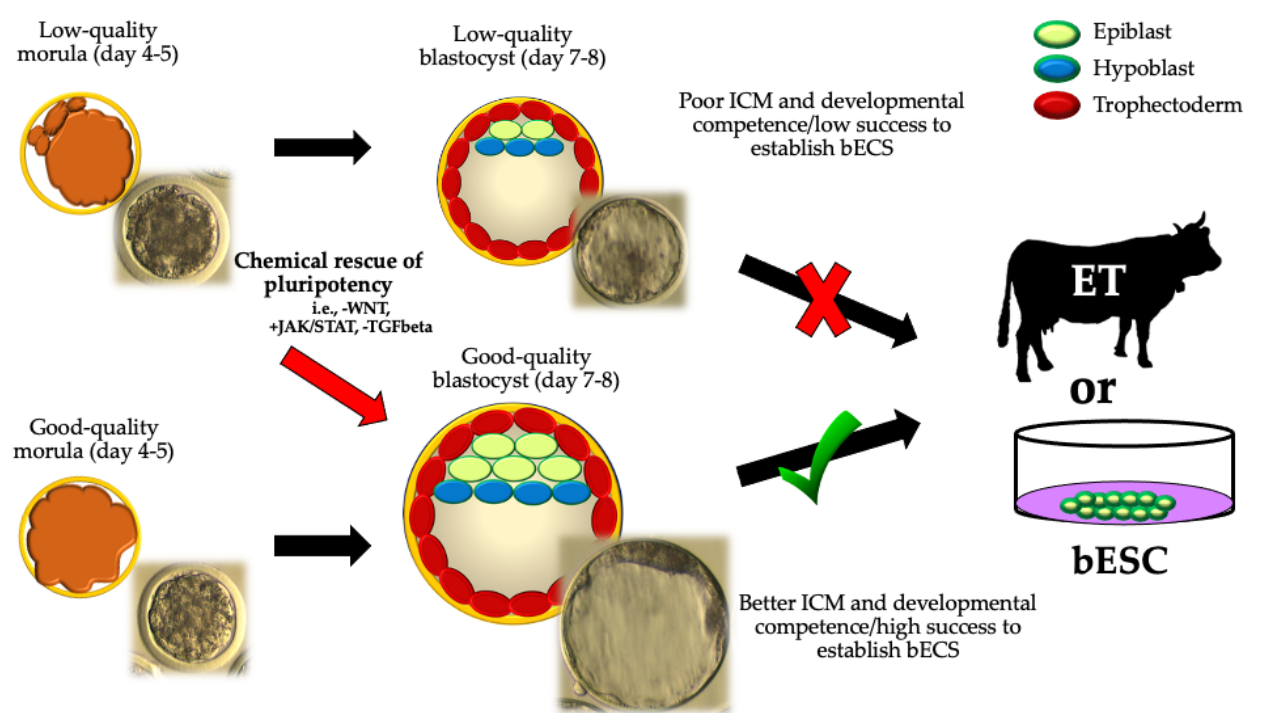
Figure 3. A theoretical approach to “rescue” in vitro developmental potential from cattle embryos of lower quality (seen as morula with delayed compaction, presence of cell debris, fragmentation and/or slower developmental kinetics). ICM: inner cell mass; ET: embryo transfer; bESCs: bovine embryonic stem cells). Low-quality blastocyst: embryo with delayed blastulation, poor symmetry, and/or cells that are loosely packed for the ICM and trophectoderm. Good-quality blastocyst: embryo with an expanded blastocoel cavity, highly symmetric, absence of cell debris or fragmentation, and highly packed ICM and trophectoderm cells, where a clearly visible ICM can be distinguished during morphological valuation. -WNT: WNT-inhibition; +JAK/STAT: JAK/STAT activation; -TGFbeta: TGFbeta inhibition.